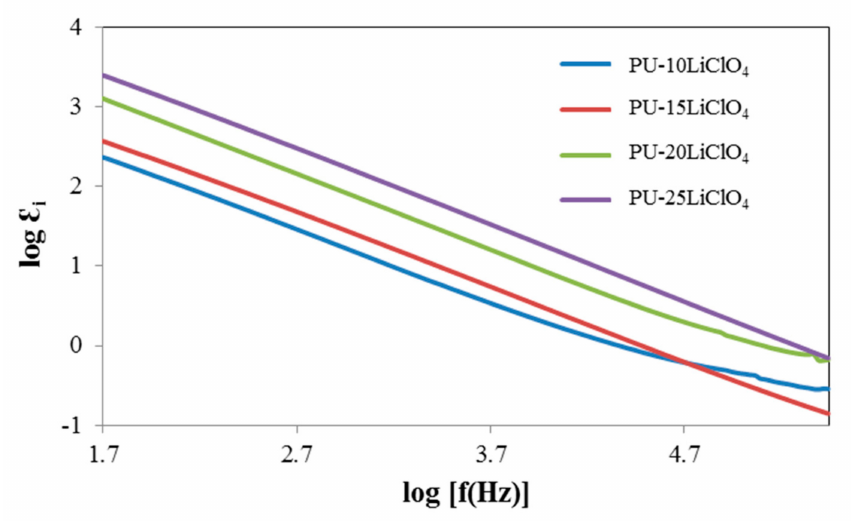
Figure 14. Dielectric loss against log frequency of PU having 10 wt.% to 25 wt.% LiClO 4